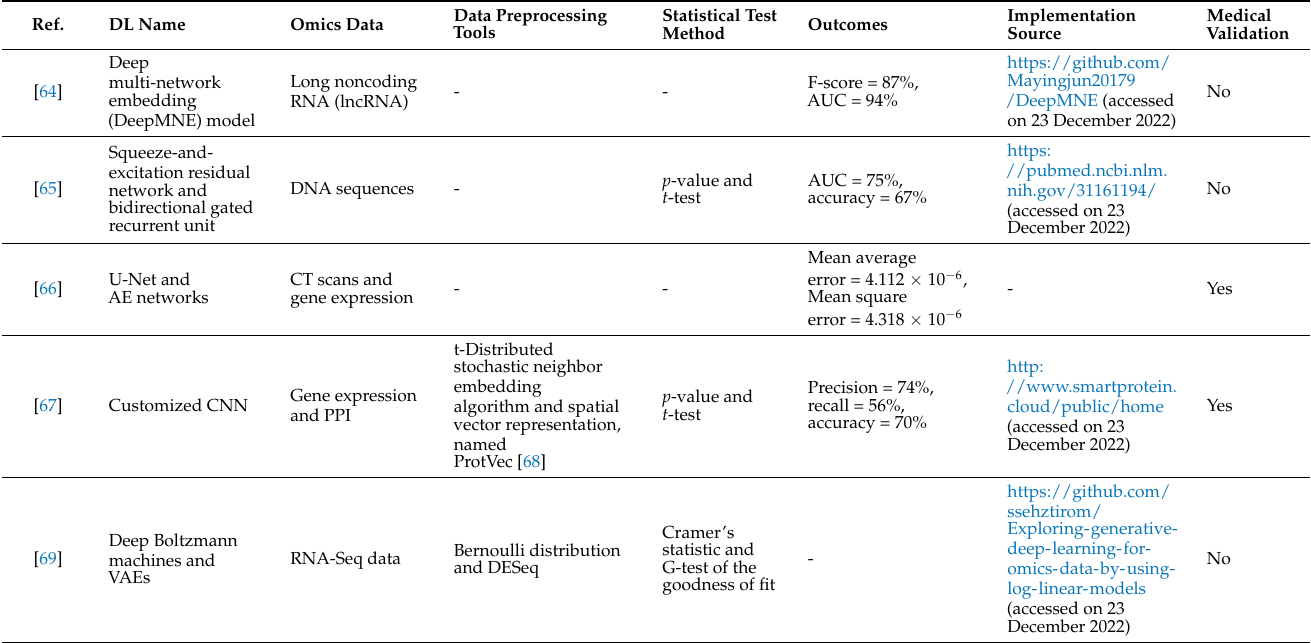
Table 3. Pathway analysis